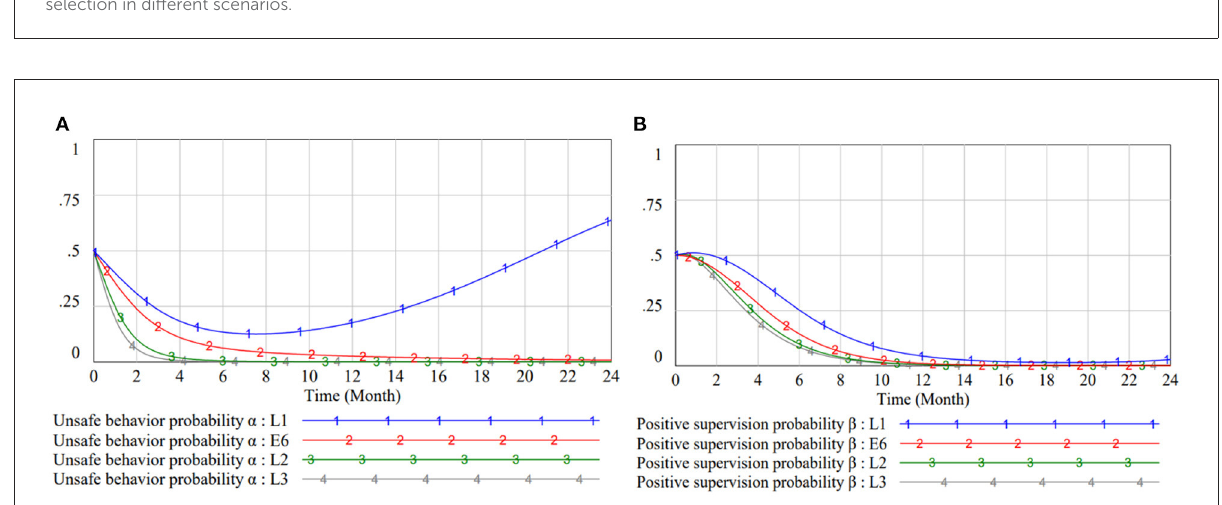
FIGURE7 Impact of F on subject strategies. (A) Impact of F on workers strategy selection in different scenarios. (B) Impact of F on managers strategy selection in different scenarios.